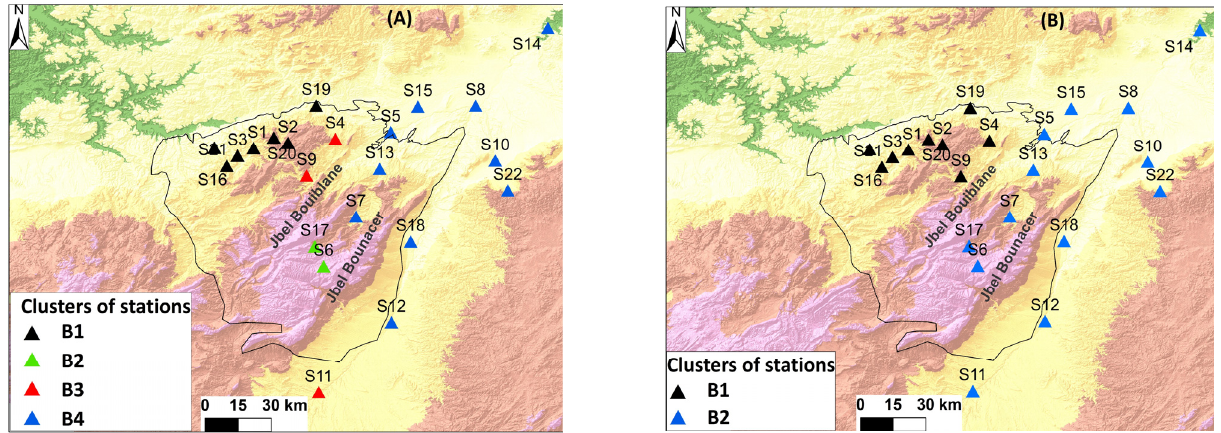
Figure 4. Clusters of stations ( A ) before and ( B ) after homogenization.